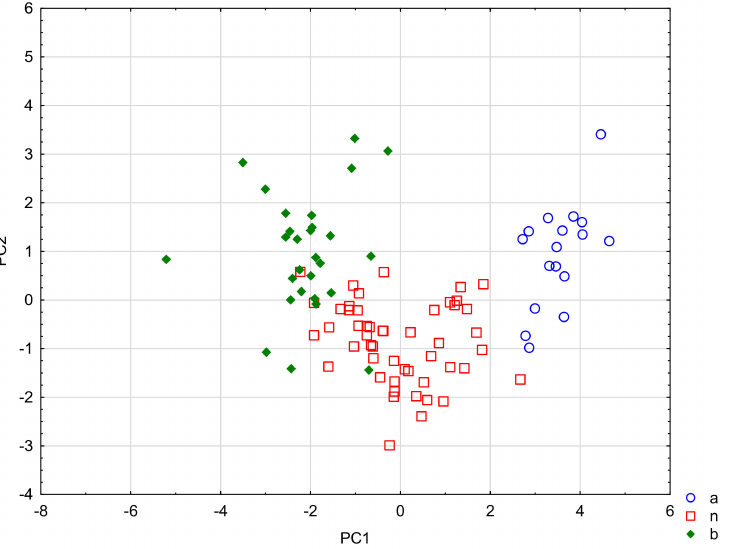
Figure 1. Discrimination against acidic ( a ), basic ( b ) and neutral drugs ( n ). The scatter plot of canonical values for root 1 relative to root 2. Discriminating variables: PhCharge, B2, pKa, M/P, log k HSA , log k IAM , NP, eL, log U/D.